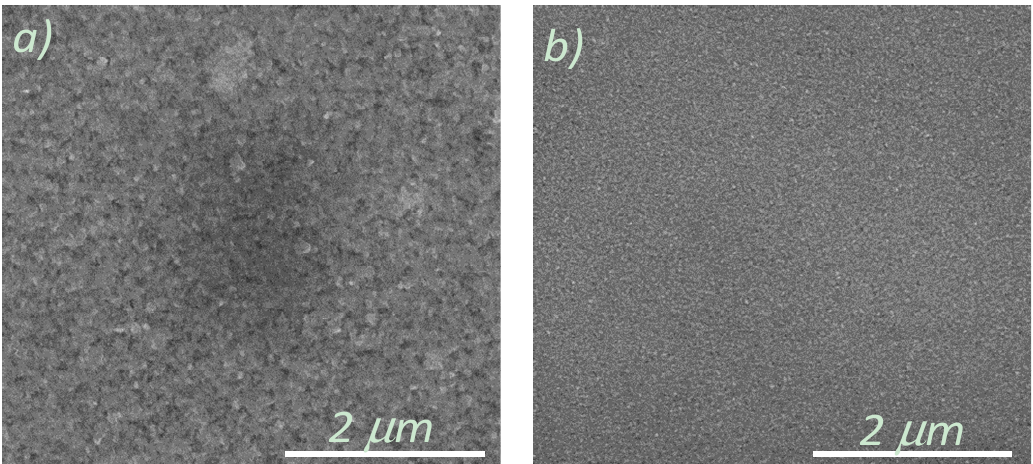
Ce Zr O 0.50 0.40 0.10 y